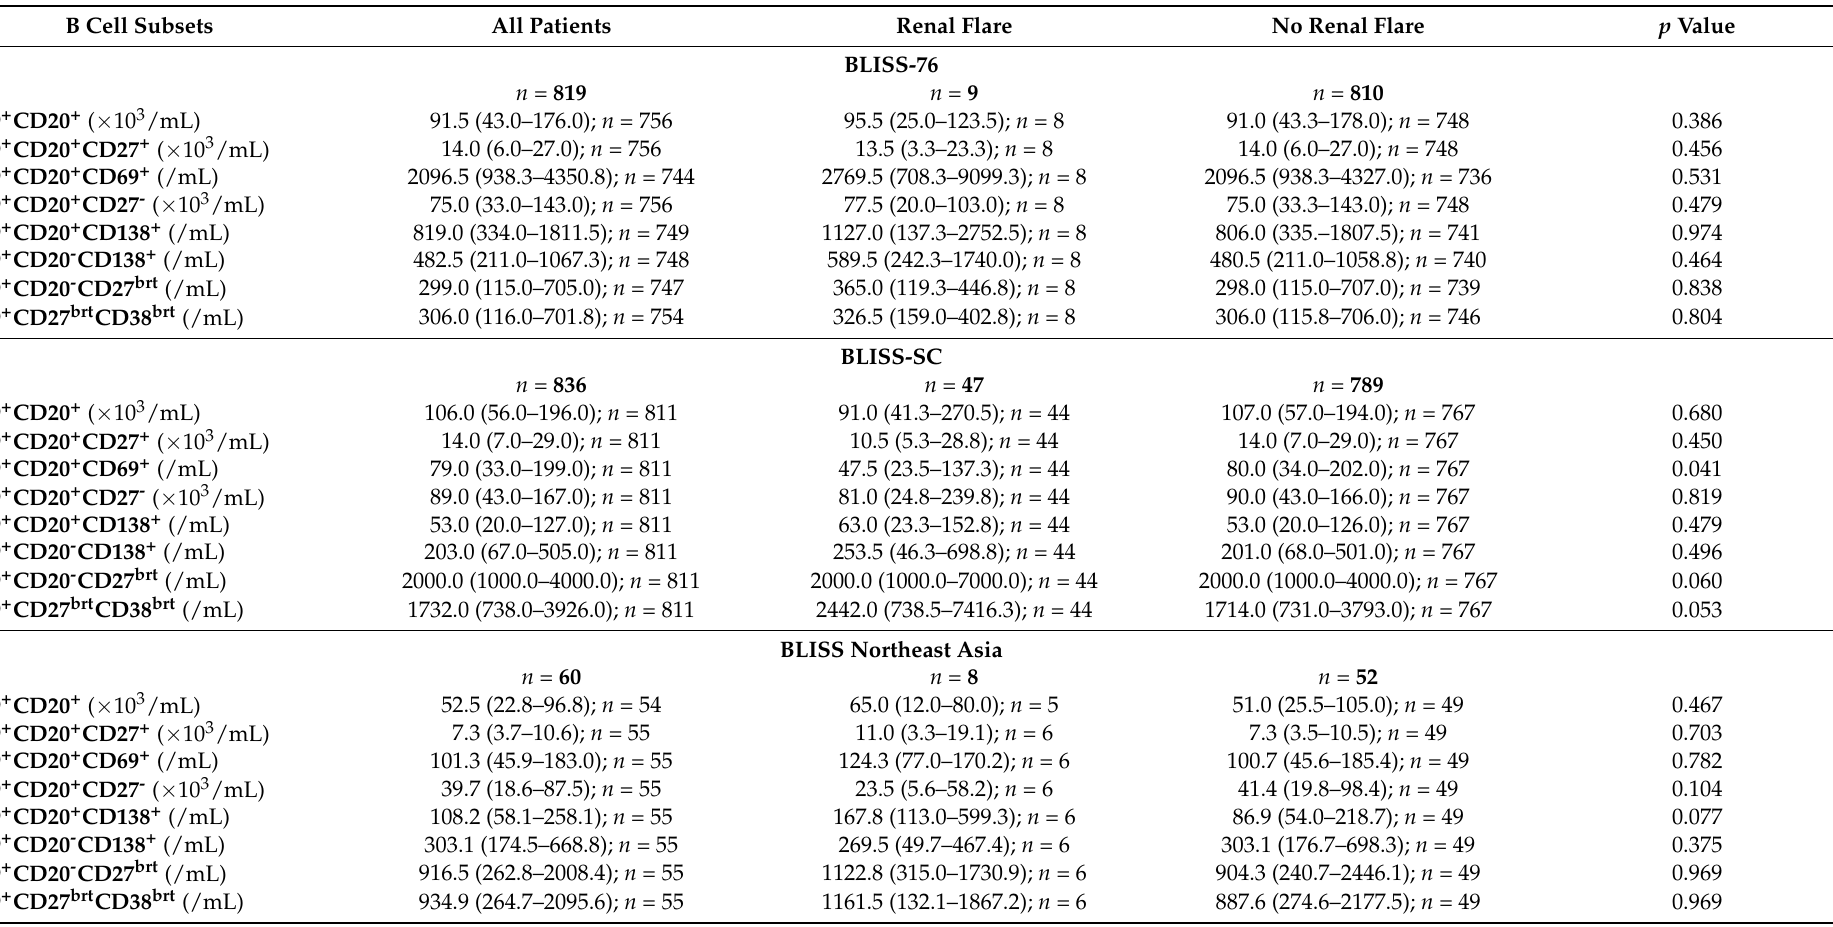
Table 2. B cell subset counts at baseline in patients who developed renal flares vs. patients who did not from baseline through week 52 in the BLISS-76, BLISS-SC, and BLISS Northeast Asia study